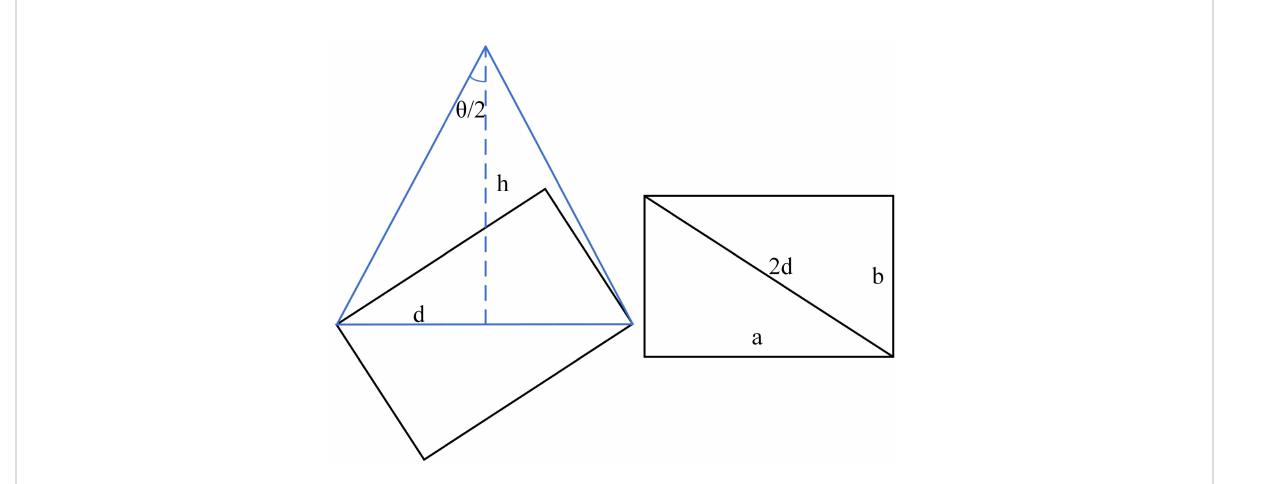
FIGURE 7 Schematic diagram of the residual fi lm area calculation process.